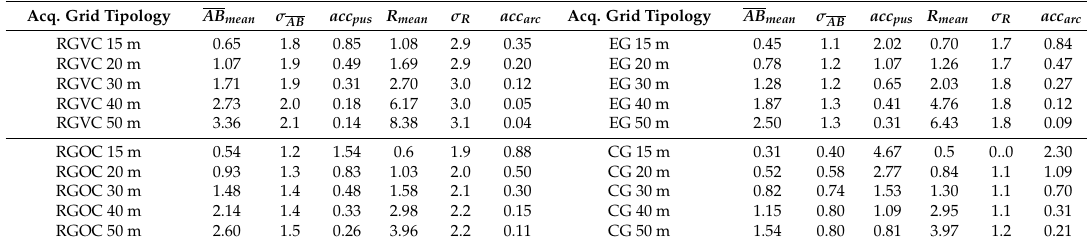
Table 5. Error in mean distances and its standard deviations in cm in the 20 surface reconstructions.